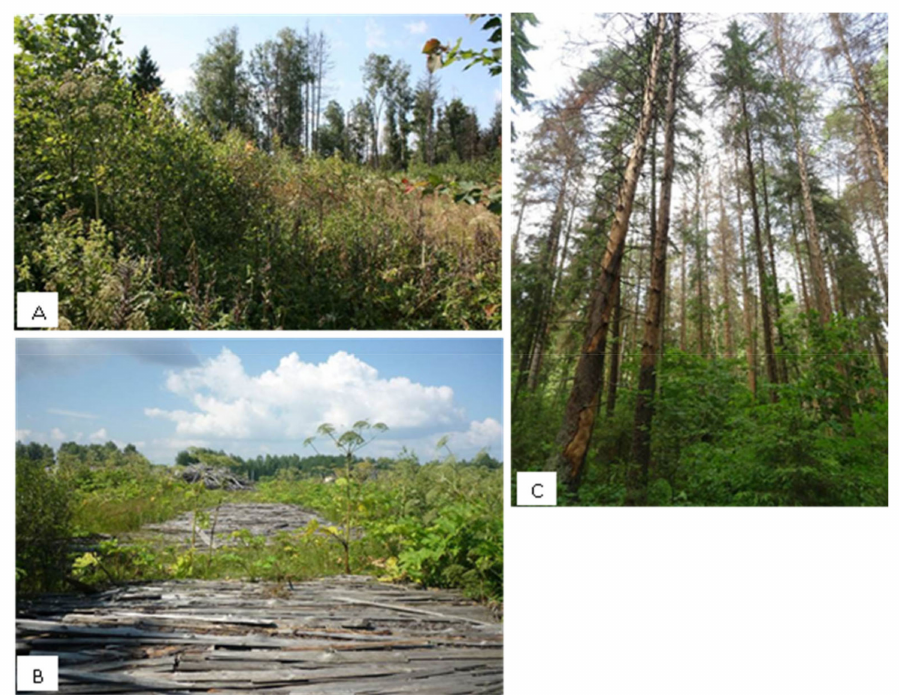
Figure 2. Some examples of the consequences of natural and anthropogenic disturbances. ( A )—Overgrown felling with small-leaved species ( Betula pendula, B. pubescens, Populus tremula, and Salix spp.); ( B )—abandoned farmland. Results of overgrowing of treeless lands of Heracleum Sosnowskyi , introduced from the Caucasus after WWII as a new fodder crop. Currently, the fight against Heracleum Sosnowskyi is being carried out on 30 thousand hectares of land near Moscow; ( C )—spruce forest affected by bark beetle Ips typographus. Monodominant and coeval spruce plantations are especially actively affected (Photo by T.V.